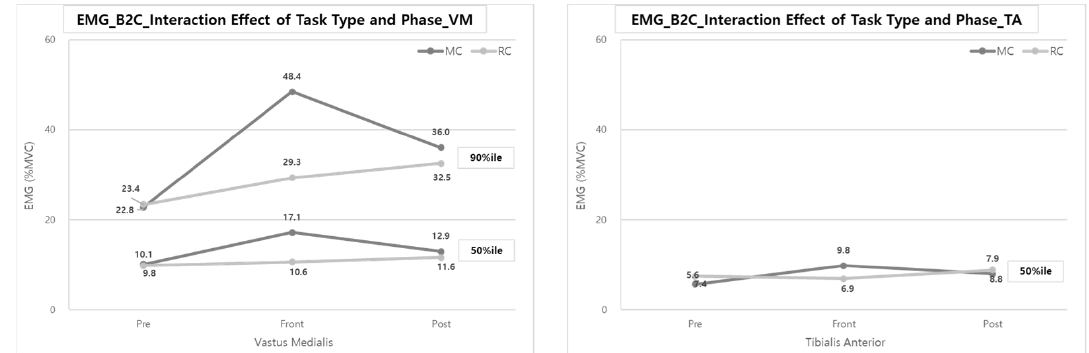
Figure 8. Interaction effect of task type and phase on VM & TA muscle activities during B2C.